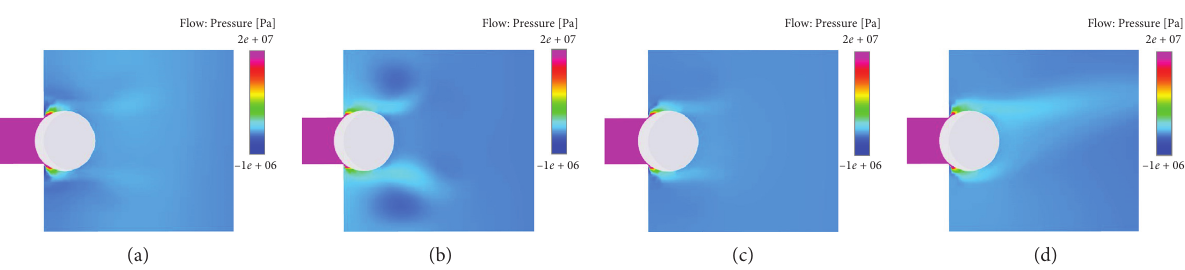
Figure 22: Pressure distribution near pilot valve seat hole under stable condition. (a) Without chamfer. (b) 20-degree chamfer. (c) 45-degree chamfer. (d) Arc